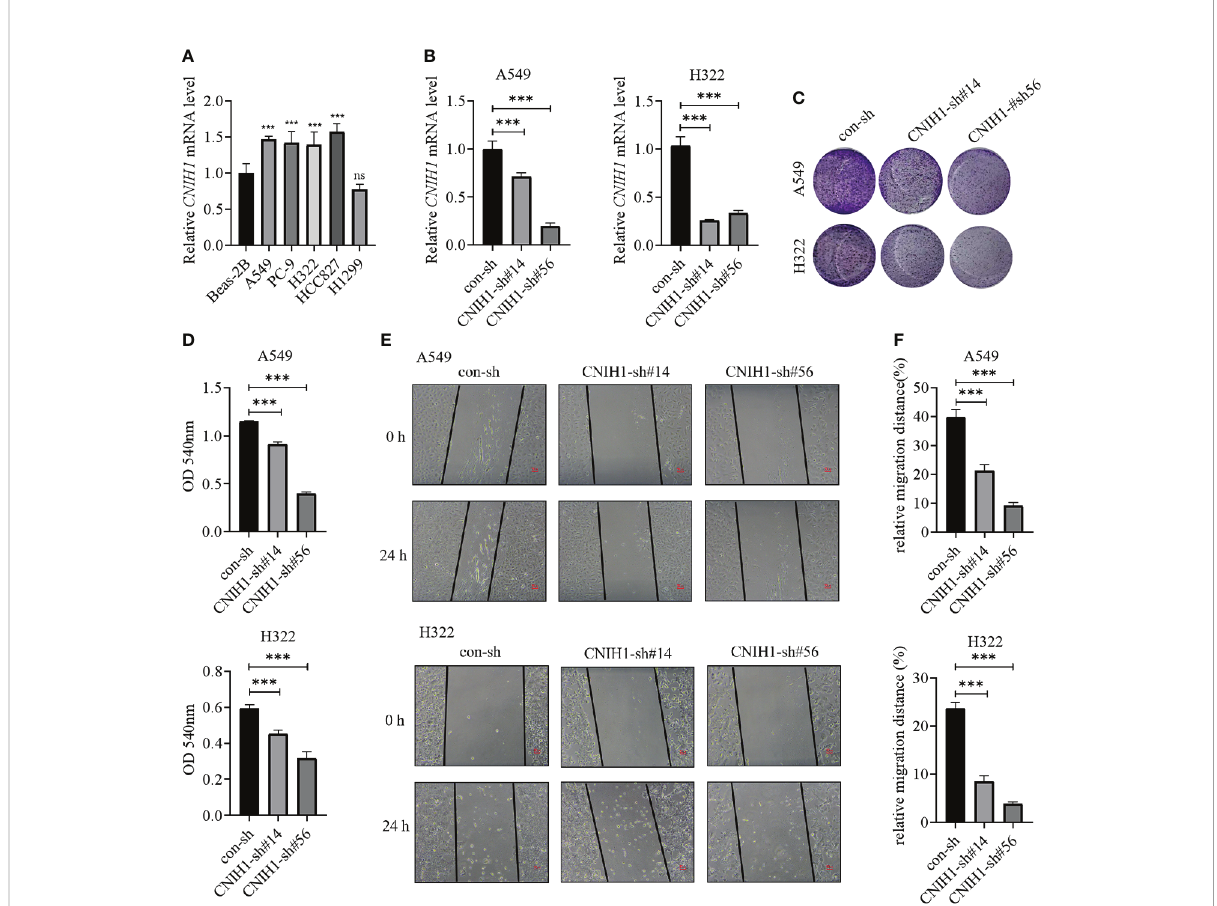
FIGURE 11 Expression of CNIH1 in LUAD cells and its function. (A) CNIH1 mRNA levels in Beas-2B and LUAD cells. (B) The mRNA levels of CNIH1 in A549 and H322 LUAD cells after its knockdown. (C, D) Colony formation assays are used to explore the functions of CNIH1 in LUAD cells. The representative images were shown in (C) . (E, F) Knockdown of CNIH1 inhibits LUAD cells migration. The wound healing assay was performed to assess the migration of A549 and H322 cells after CNIH1 knockdown. Representative images were shown in (E) . *** p <0.001 ns, no signi fi cance. All experiments were repeated at least three